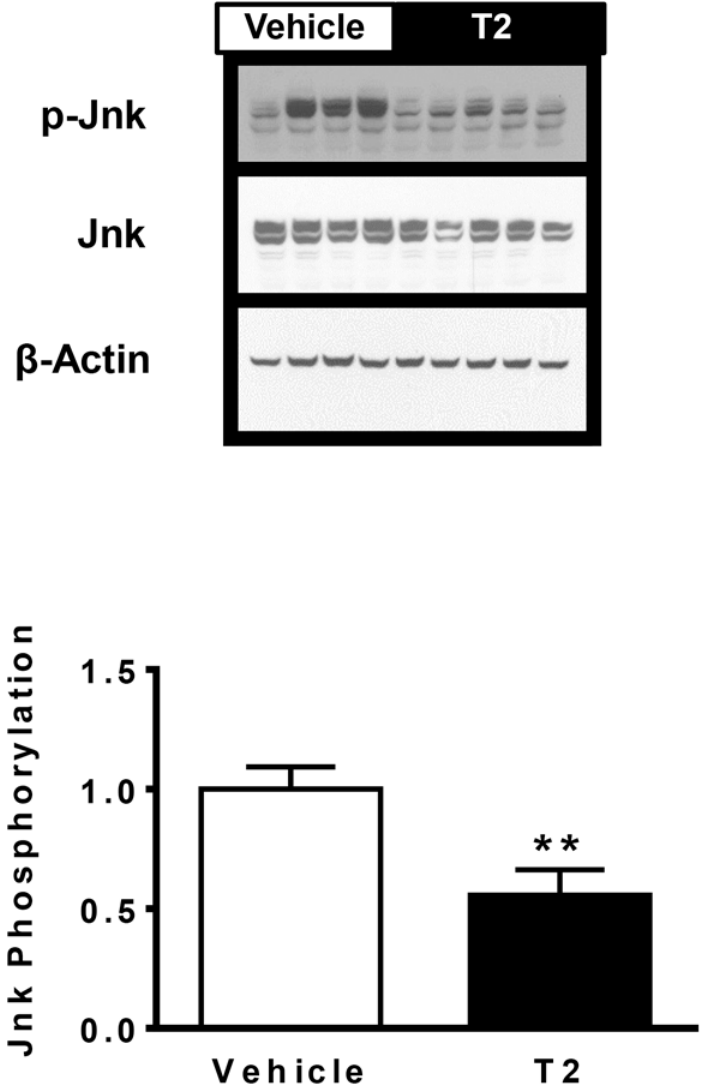
Fig 4. Hepatic c-Jun N-terminal kinase (JNK) phosphorylation assessed by Western blot. Representative immunoblots displayed. Data quantitated as ratio of phosphorylated JNK to total JNK abundance, normalized to vehicle treatment. ( ** P < 0.01; Vehicle treatment: n = 8; T2 treatment: n = 9).